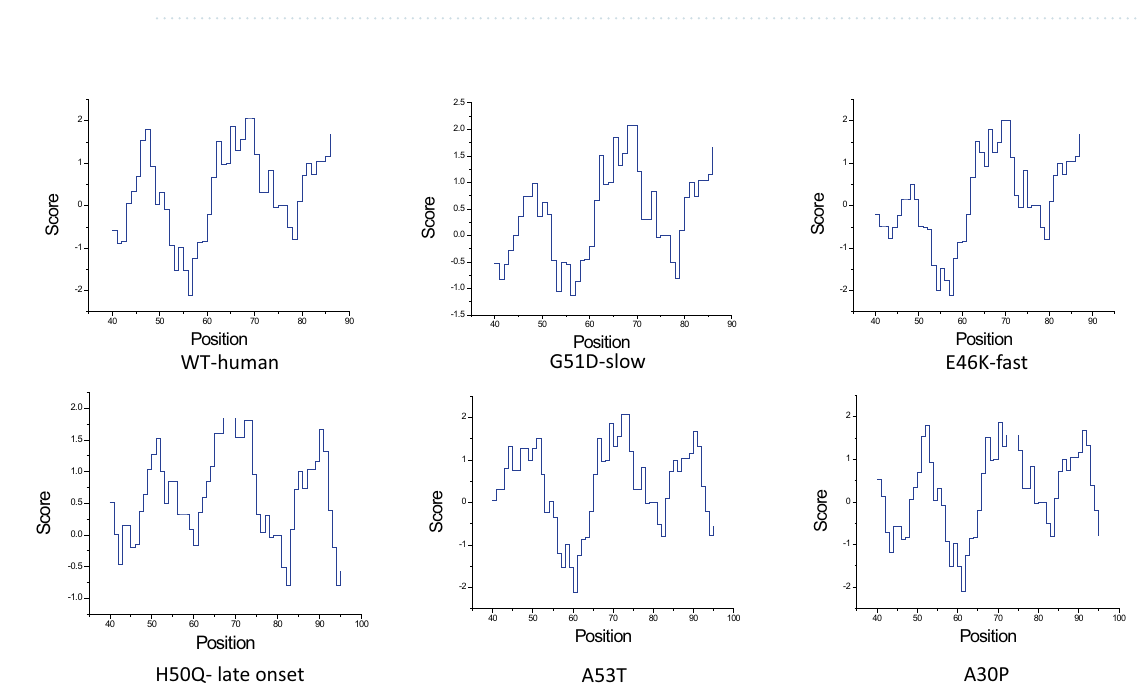
Figure 7. Comparative study on WT-human, G51D-slow and E46K-fast based on variation in Van der Waal’s clashes.